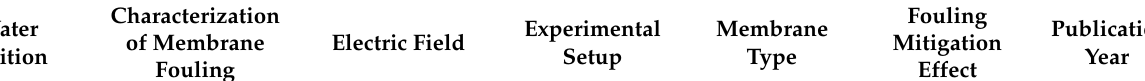
Table 1. Summary of electrofiltration studies using